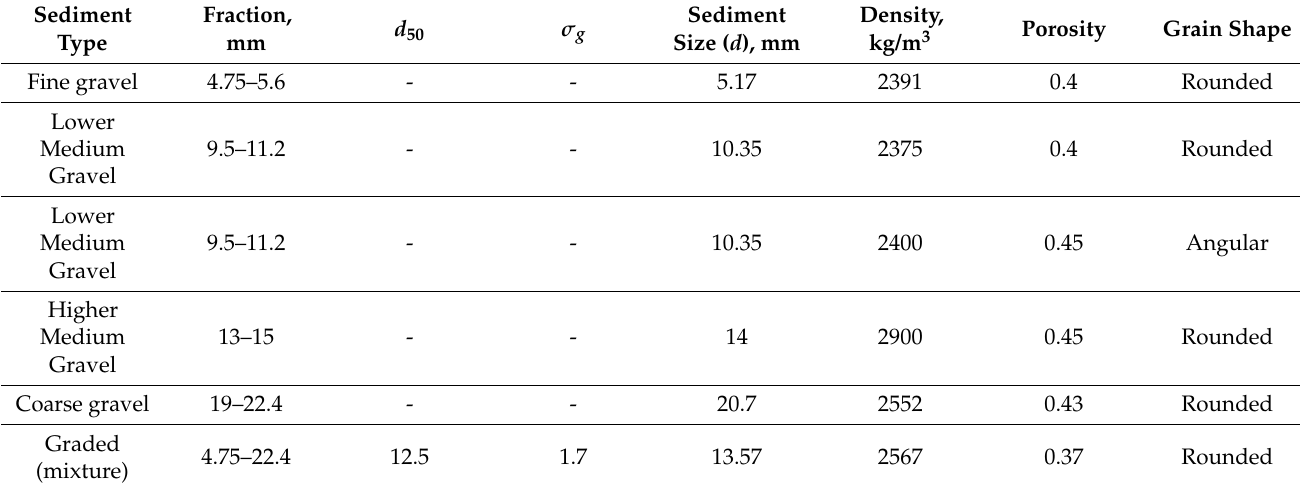
Table 1. Physical properties of bed sediments used in this